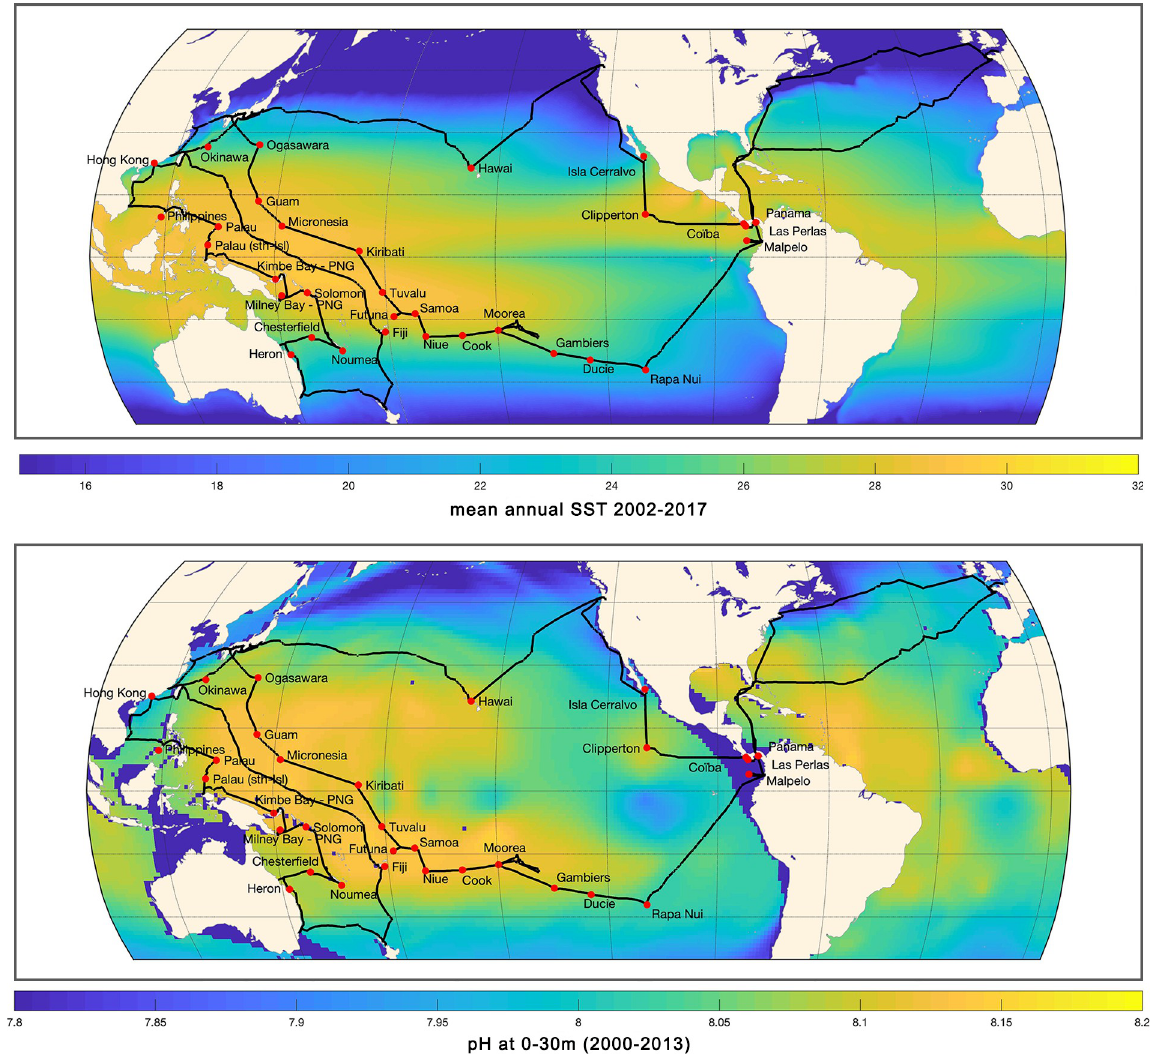
Fig 1. Map showing the route of the Tara Pacific expedition and the sampling sites (red spots) throughout the Pacific Ocean (July 2016 to October 2018) as well as the mean annual SST (top) and pH (bottom). Global annual SSTs were extracted from the MODIS-Aqua satellite and correspond to global mapped climatologies of the period from 2002 to 2018 (NASA Goddard Space Flight Center), whereas pH values originate from the GLODAPv2 database [59, 60], with mean data displayed corresponding to the 0–30 m depths between 2000 and 2013. GLODAP, Global Ocean Data Analysis Project; MODIS, Moderate Resolution Imaging Spectroradiometer; NASA, National Aeronautics and Space Administration; PNG, Papua New Guinea; SST, sea surface temperature.